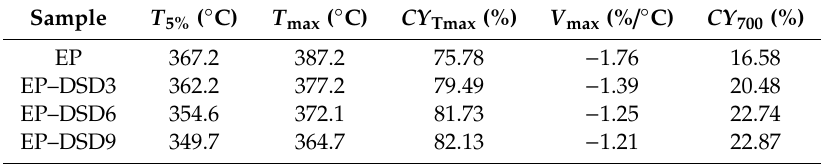
Figure 8. TG ( a ) and DTG ( b ) curves of neat EP and EP–DSD thermosets under nitrogen atmosphere. Table 4. Data of neat EP and EP–DSD thermosets under nitrogen atmosphere.